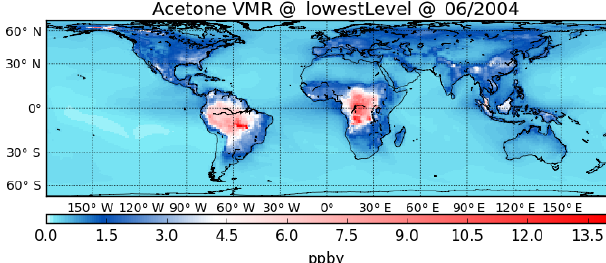
Figure 6. Monthly mean acetone volume mixing ratio in the lowest model layer (layer 90, height of about 20m above surface) for June 2004, 6 months after initialisation of the OH-chem(megan-offl) sim- ulation (see Sect.